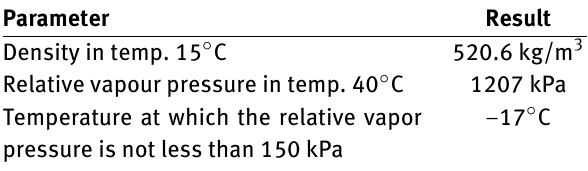
Table 2: Selected basic properties of LPG fuel.